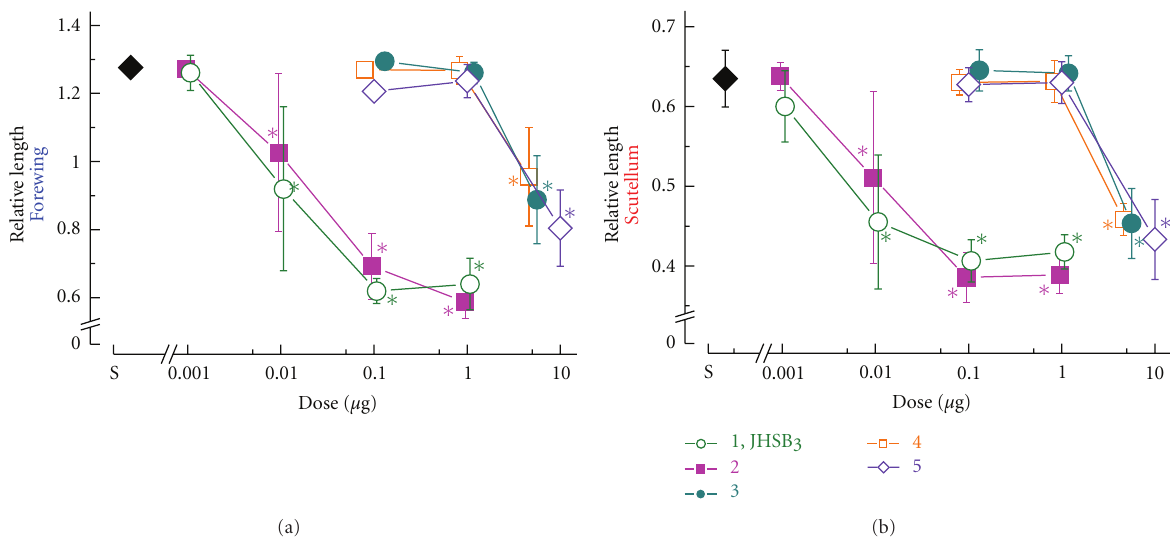
Figure 7: Juvenilizing activity of JHSB 3 ( 1 ), its stereoisomers and 10 R -JH III on Plautia stali . Last instar nymphs were treated with a test compound. Following the final molt, lengths of forewing (a) and scutellum (b) relative to the width of pronotum were determined. S on the horizontal axis indicates solvent control. Each datum point and error bar represents average value ± SD ( n = 8–18). Asterisks indicate that the average value was significantly di ff erent from that of the solvent control (Steel’s test, P < 0 . 05)